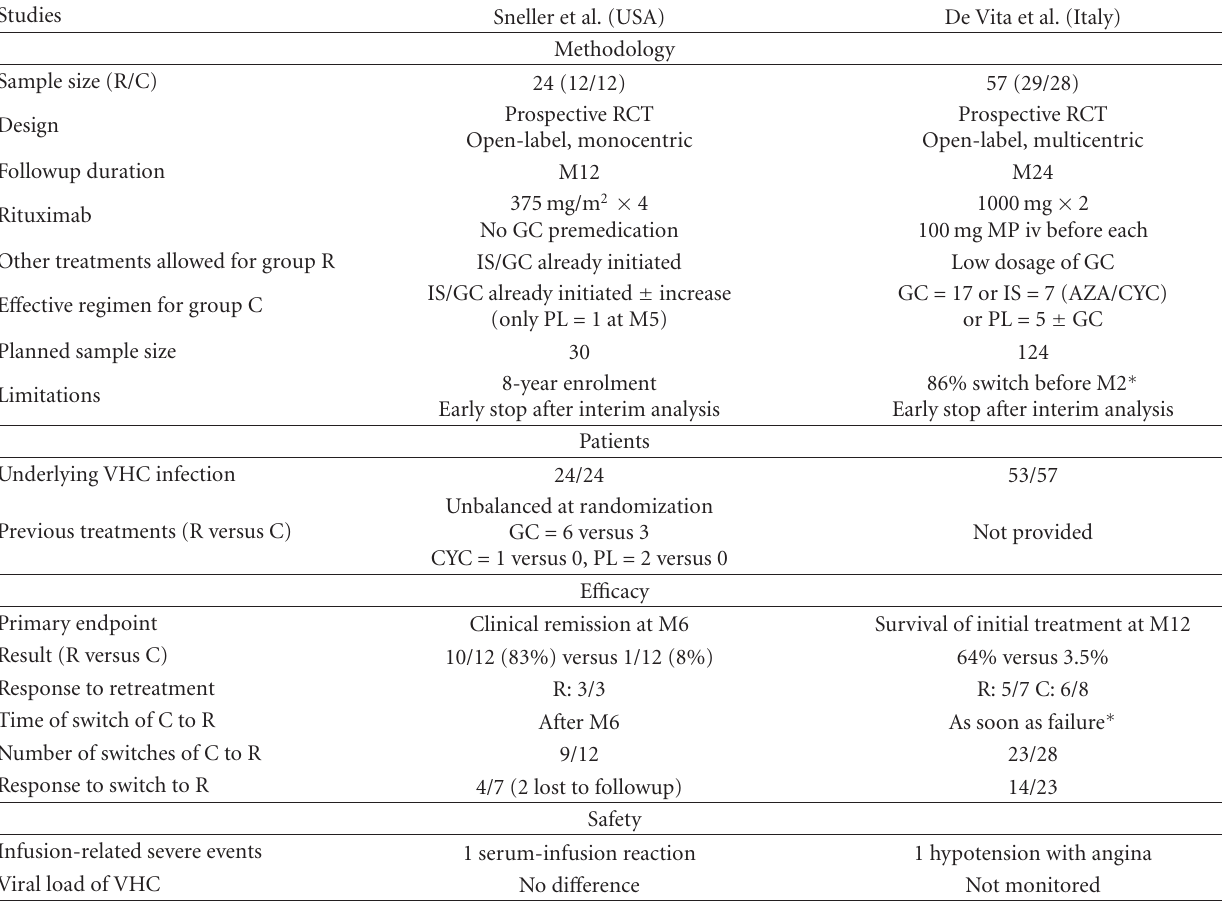
Table 1: Prospective randomized controlled trials comparing rituximab (R) with a classical immunosuppressive regimen (C).